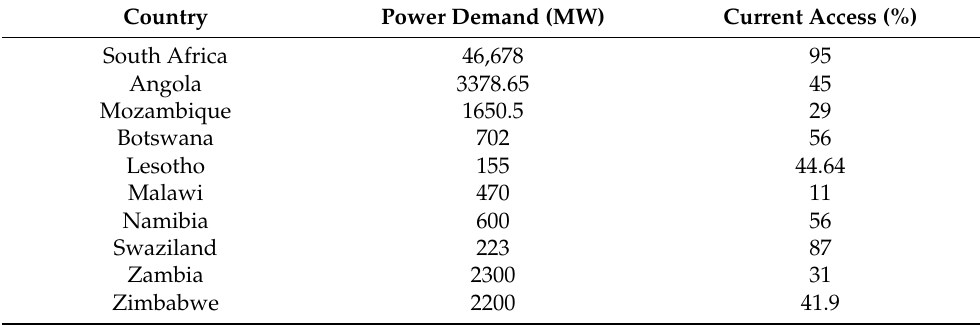
Table 3. Power demand and current electricity access in the Southern African